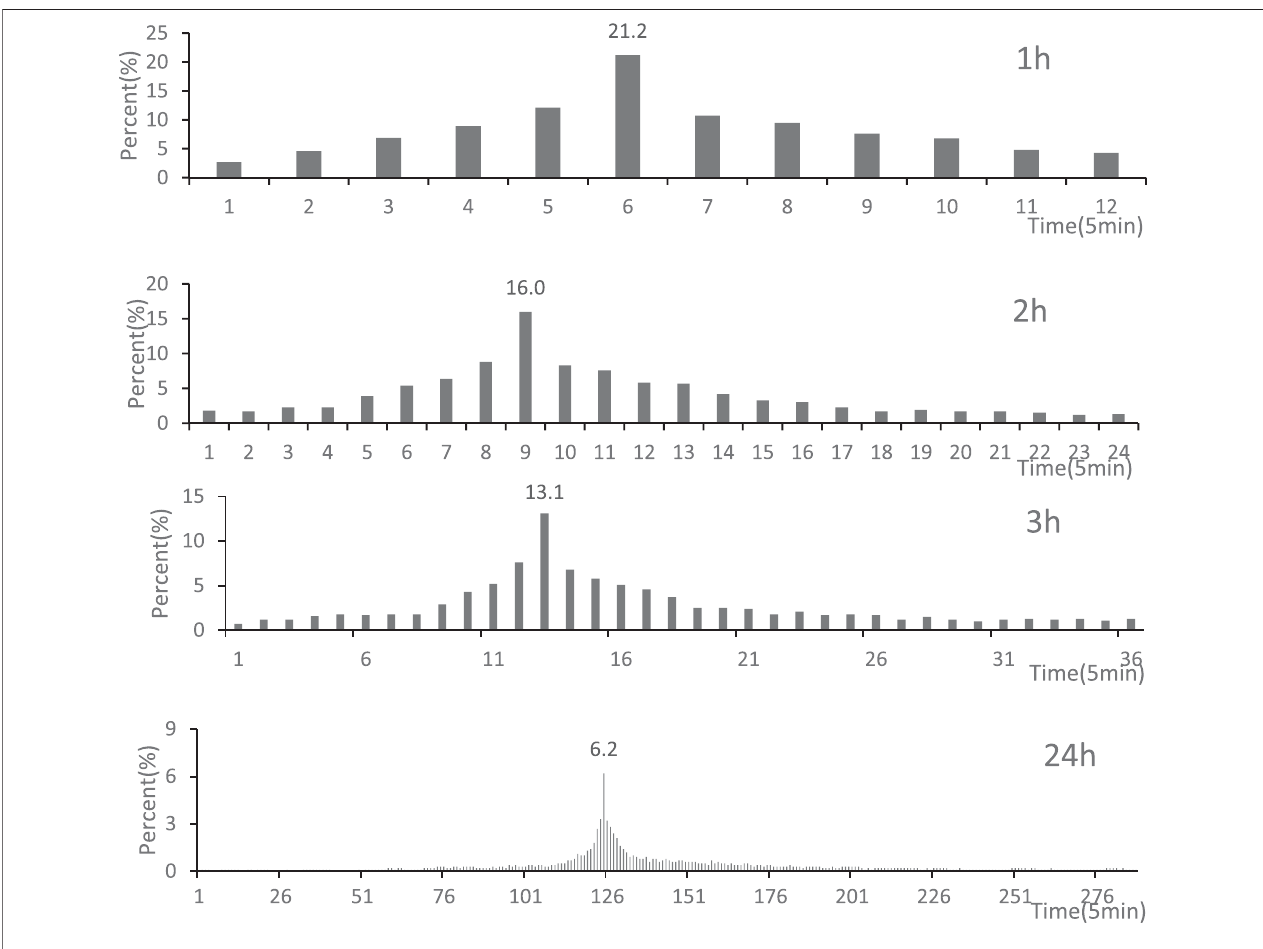
FIGURE 4 | Four durations of rainstorm hyetograph designs obtained with the NRMR method.